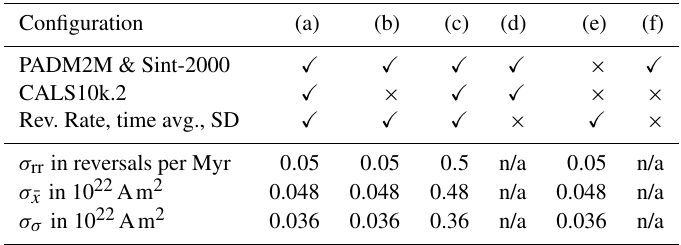
Figure 7. Parameter estimation results. (a) PSDs of data and model. Orange: PSD of Sint-2000. Red: PSD of PADM2M. Dashed purple: PSD of CALS10k.2. Solid purple: PSD of CALS10k.2 at frequencies we consider ( y hf ). Grey (low frequencies): 5 × 10 3 samples of the error model ε lf added to y lf . Grey (high frequencies): 5 × 10 3 samples of the error model ε hf added to y hf . Dark blue: PSDs of 100 posterior samples of the Myr model (with smoothing). Turquoise: PSDs of 100 posterior samples of the kyr model with uncorrelated noise. (b) Sint-2000 (orange), PADM2M (red) and a realization of the Myr model with smoothing and with posterior mean parameters (blue). (c) CALS10k.2 (purple) and a realization of the kyr model with correlated noise and with posterior mean parameters of the kyr model (turquoise). Table 5. Configurations for several Bayesian problem formulations. A checkmark means that the data set is used; a cross means it is not used in the overall likelihood construction. The standard deviations ( σ ) define the Gaussian error models for the reversal rate, time-averaged VADM and VADM standard